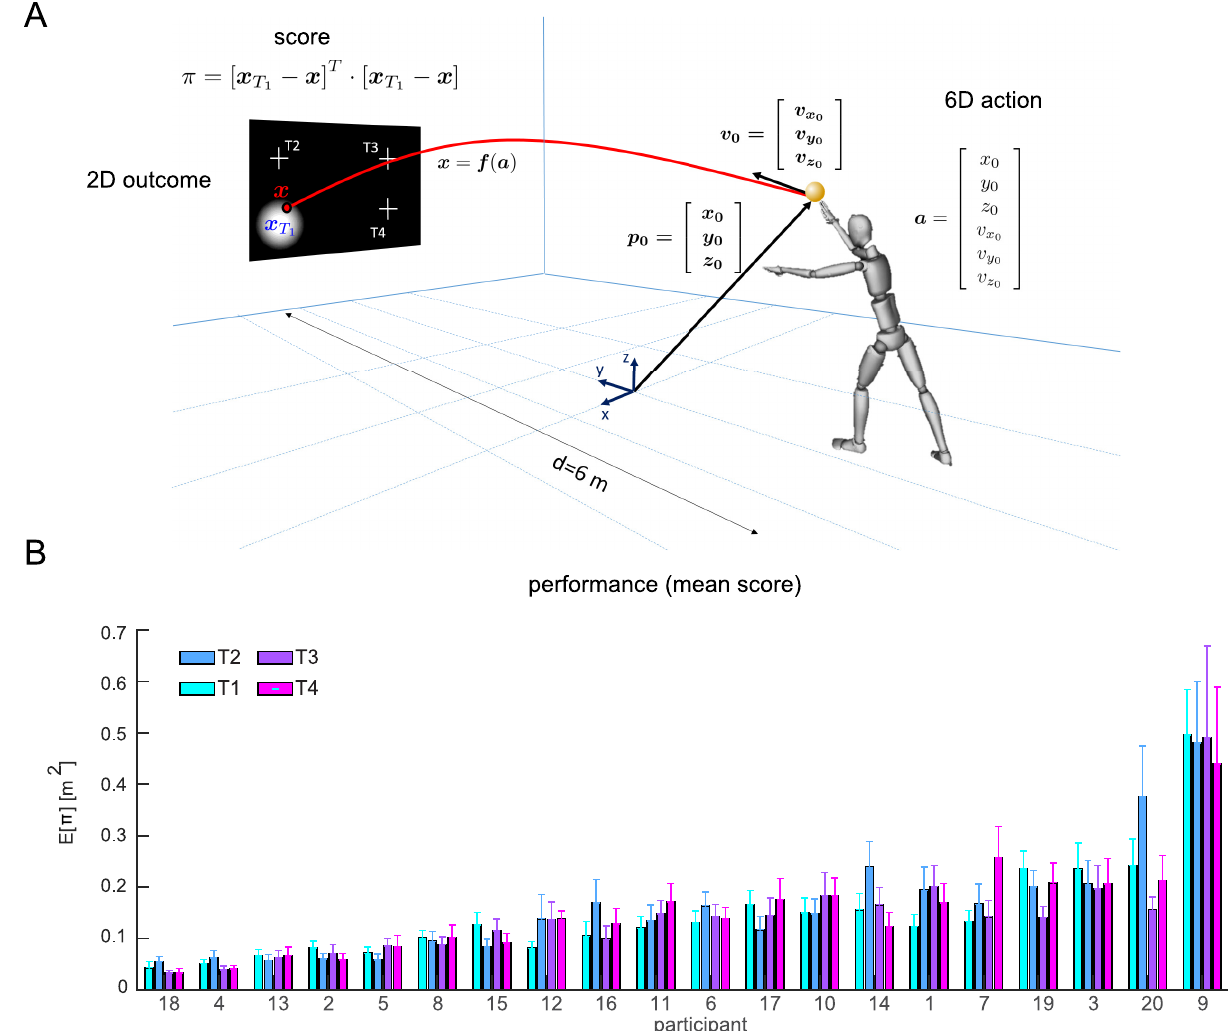
Fig 1. Unconstrained throwing task and experimental performance. (A) Schematic representation of the unconstrained overarm throwing task considered in this study as an example of a complex motor skill. The release parameters characterizing a throwing action are six-dimensional (three position components and three velocity components). (B) Performance (mean squared error ± SE) across participants (n = 20) and four targets.